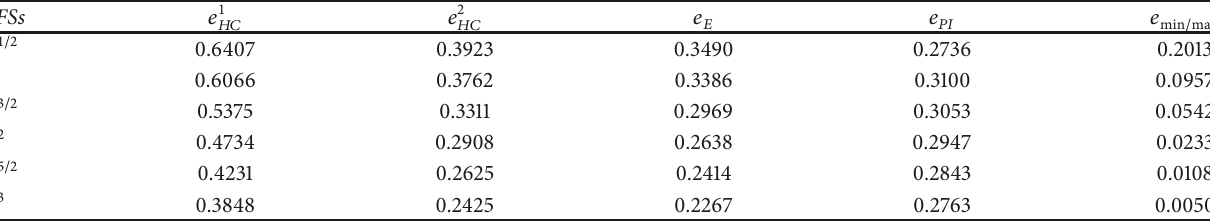
Table 2: Degree of fuzziness from entropies of different